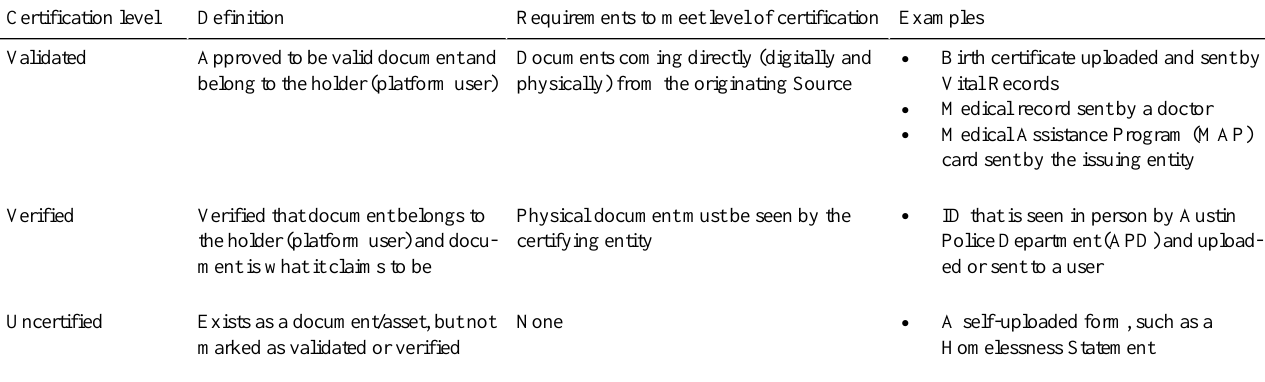
Table 3. Level of document